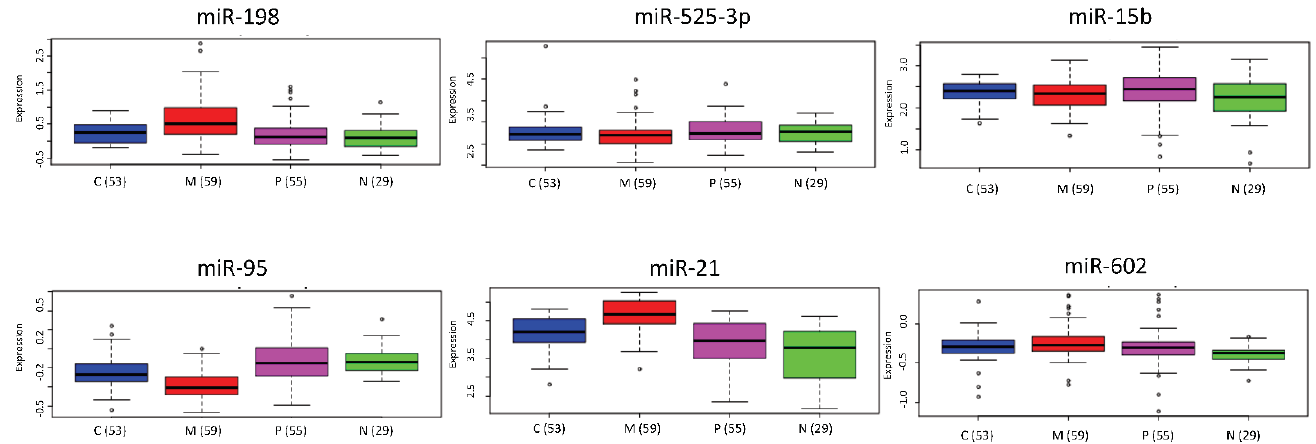
Figure 3. Boxplots of the six most significant miRNAs expression distribution in four subtypes of Glioblastoma (GBM) of The Cancer Genome Atlas (TCGA) patients.